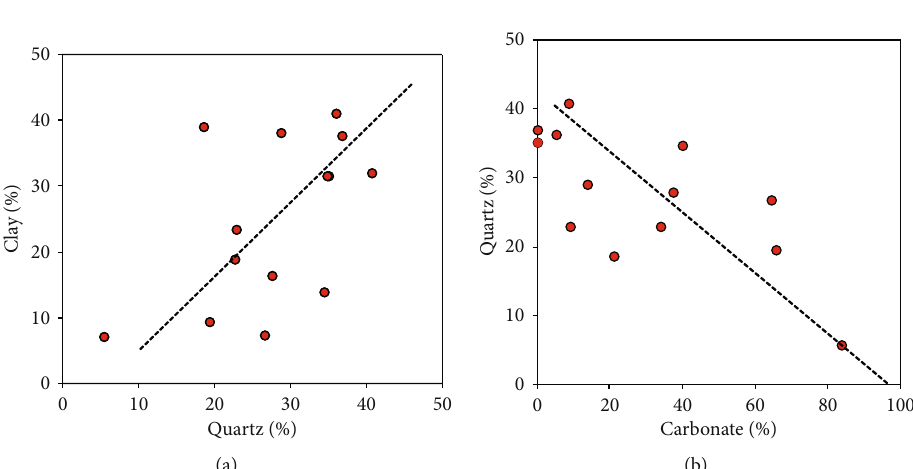
Figure 3: (a) Cross-plot of quartz versus clay minerals of the shale samples. (b) Cross-plot of the carbonate minerals versus quartz of the shale